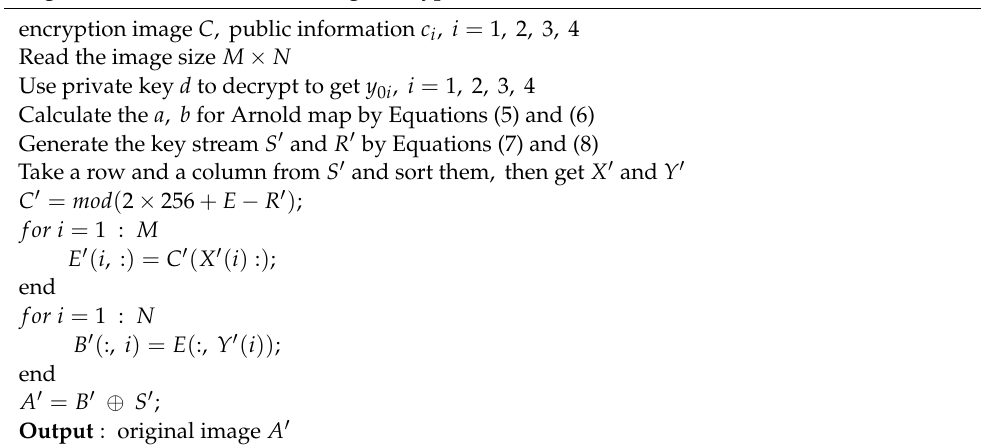
Algorithm 2: Pseudocode of image